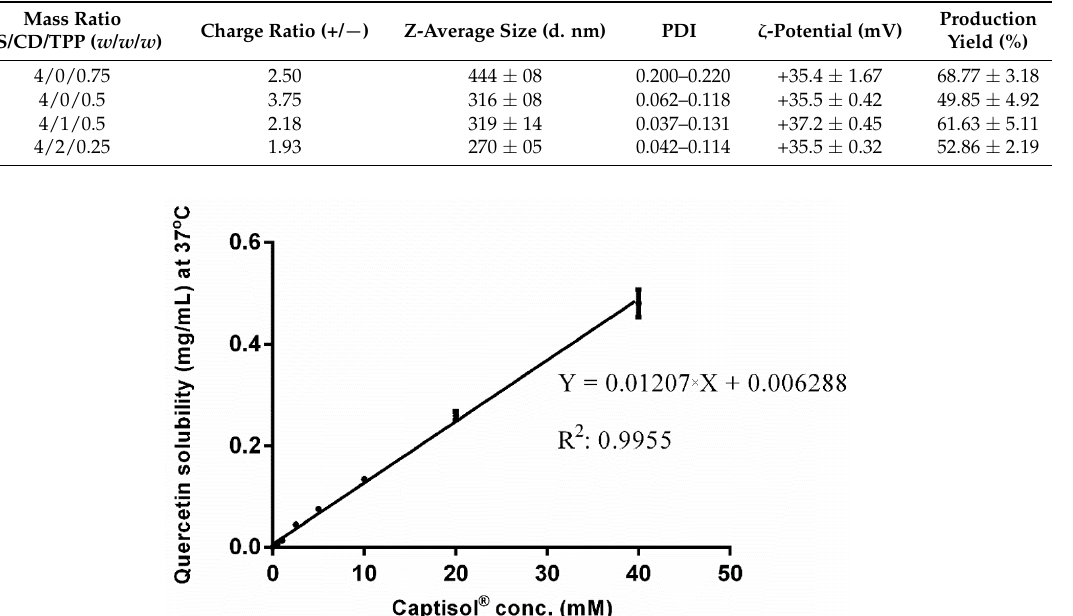
Table 3. Physicochemical properties of CS 70/5 /SBE β CD/TPP quercetin-loaded nanoparticles (mean ± S.D., n = 3).